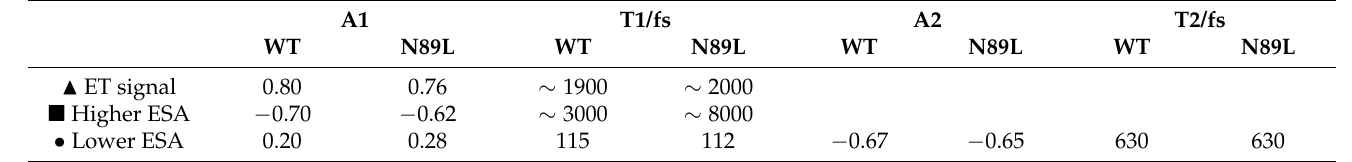
Table 1. Results of the parallel (multi)exponential models used to fit the traces at (17,066, 15,100) cm − 1 (triangle, ET signal), (17,066, 16,700) cm − 1 (higher ESA, square) and (17,066, 15,850) cm − 1 (lower ESA, circle); positive (negative) amplitudes indicate rising (decaying)